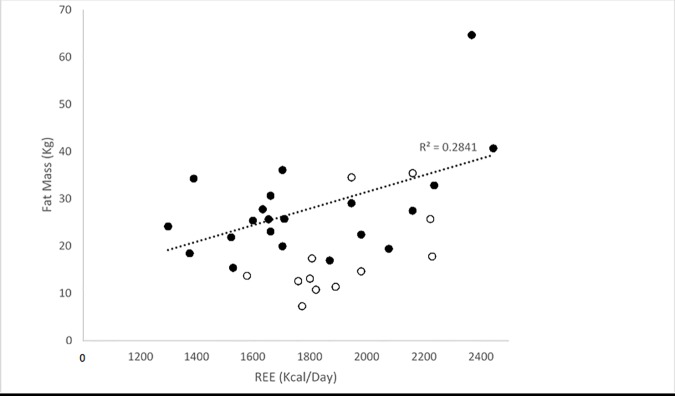
REE and Fat Mass (Kg) relationship in BeMD (closed circles) and Control (open circles) participants.Kg = Kilograms; REE = Resting Energy Expenditure; Kcal = Kilocalories.